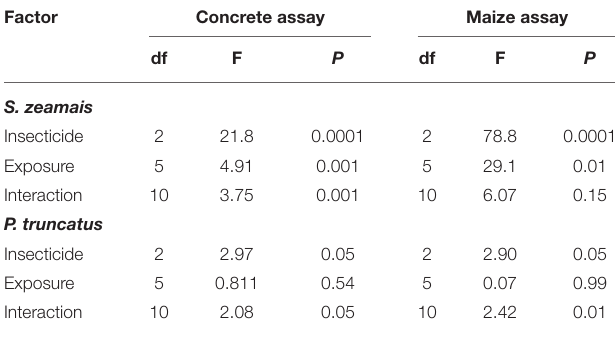
TABLE 4 | Summary of statistical model results for GLM of velocity by S. zeamais and P. truncatus in the after exposure in the concrete assay and maize assay. Factor